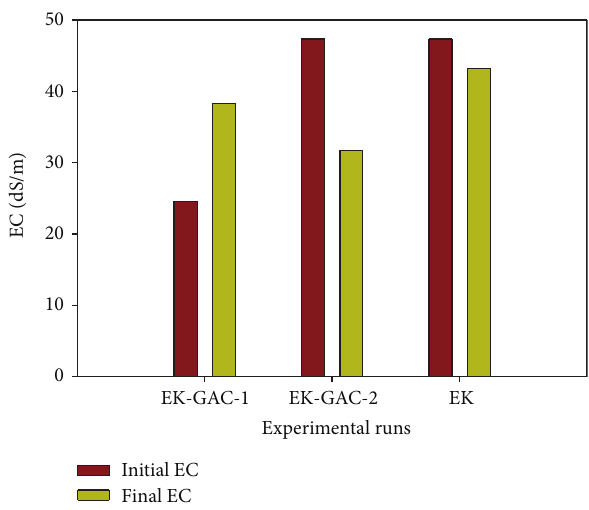
Figure 6: Variation of electrical conductivity. energy consumption. The average temperature recorded for EK-GAC-2 and EK is 28.5 and 30 ∘ C, respectively. For the same tests, the maximum temperature is 34.6 and 40.5 ∘ C, respectively. High temperature will reduce the soil moisture content due to pore fluid evaporation and subsequent reduc- tion in current and electroosmotic flow.